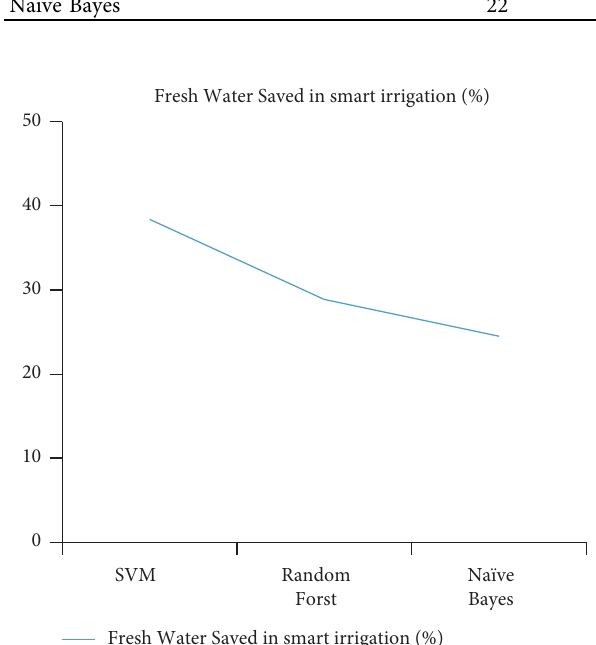
Figure 6: Graphical representation of fresh water saved in smart